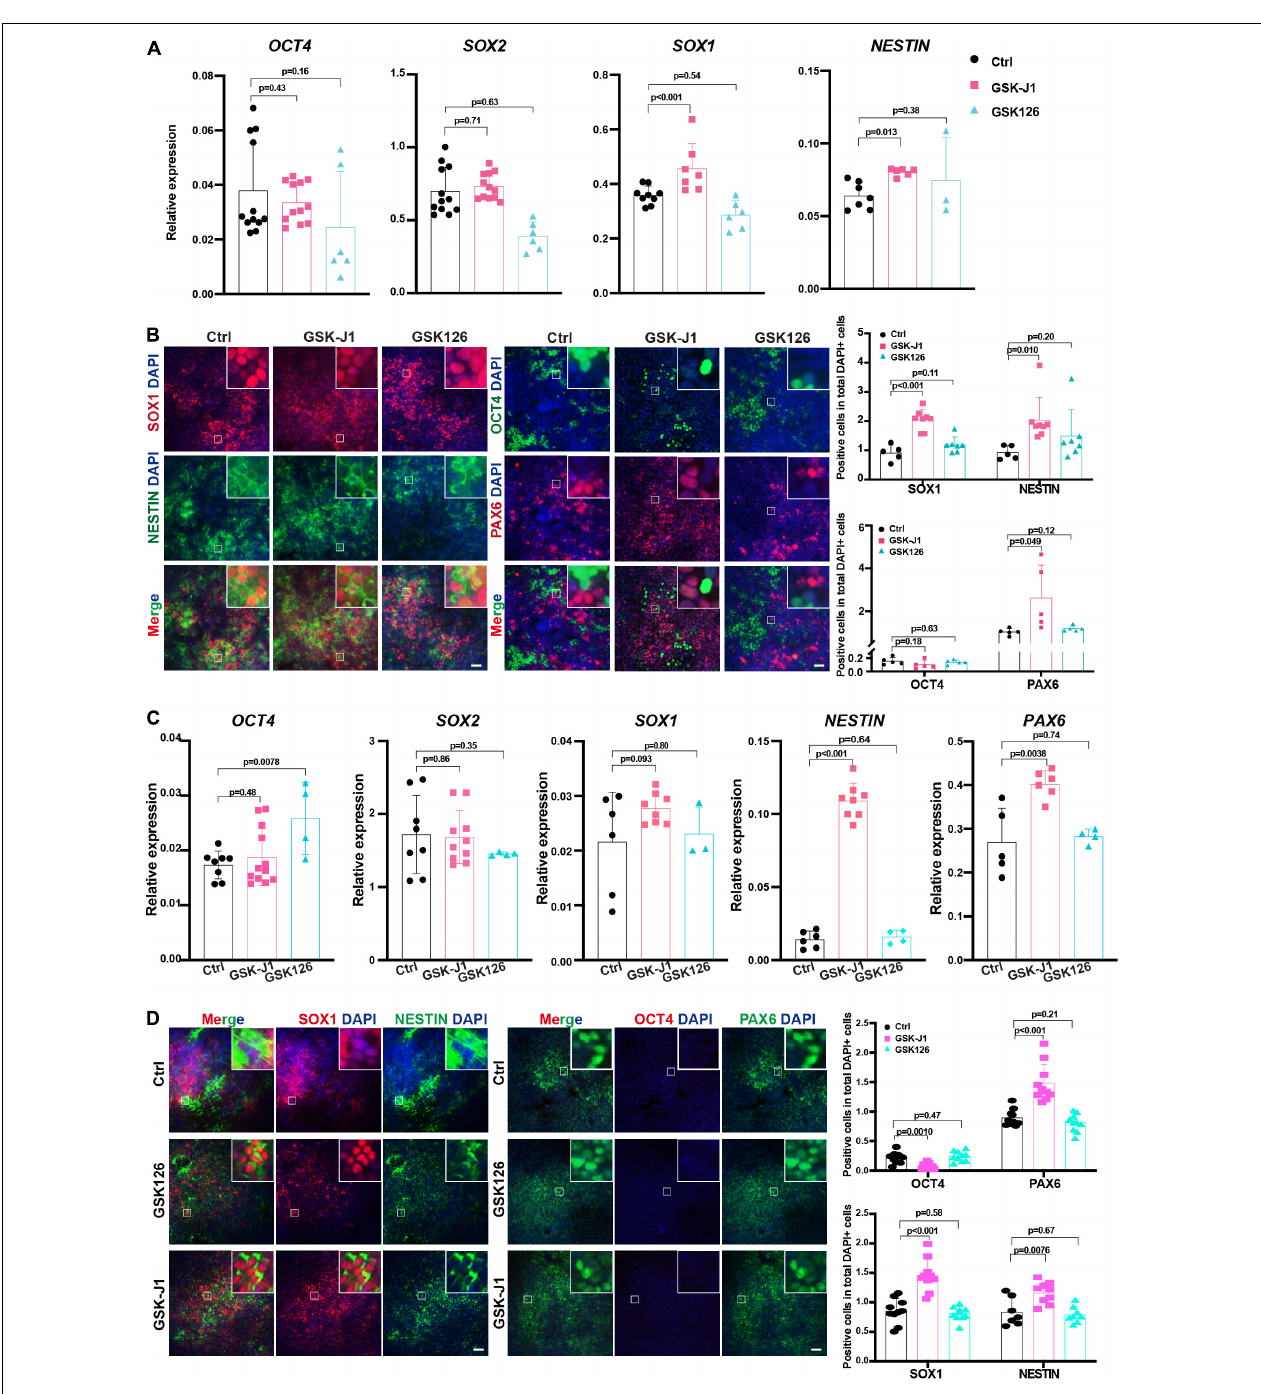
FIGURE 7 | GSKJ1 improved neuroectoderm differentiation efficiency from human PSCs. (A,B) The RT-qPCR result (A) of the expression differences and immunofluorescence staining (B) of pluripotent or neural markers of HUES8 cells at differentiation day 7 upon adding GSKJ1 or GSK-126 or vehicle control. Scale bar = 50 µ m. (C,D) The RT-qPCR result (A) of the expression differences and immunofluorescence staining (B) of pluripotent or neural markers of WTC cells at differentiation day 7 upon adding GSKJ1 or GSK-126 or vehicle control. Scale bar = 50 µ m.